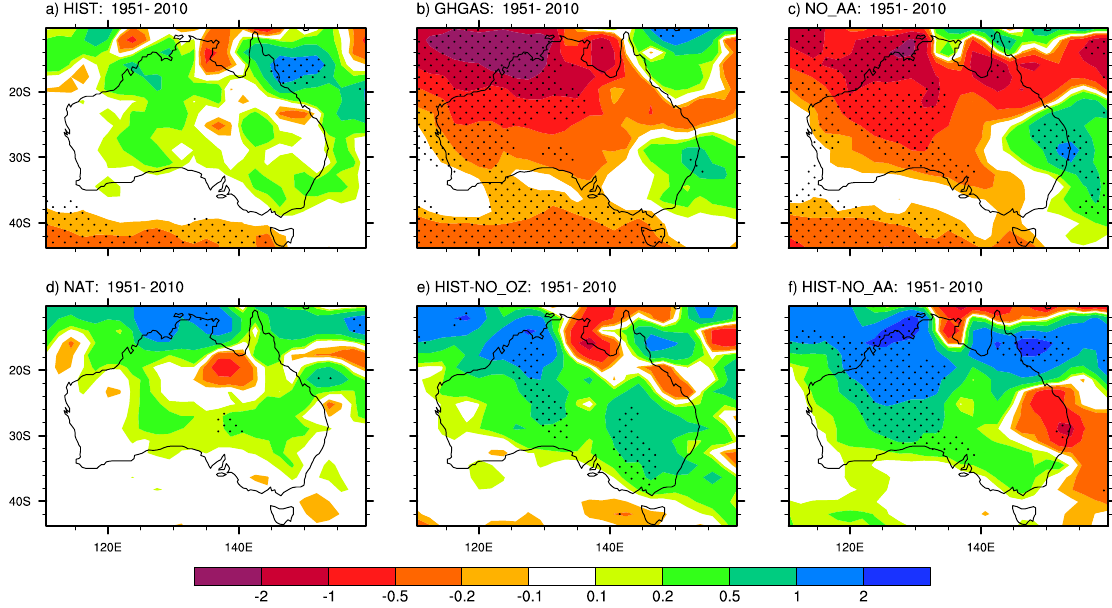
Fig. 13. Simulated DJFM rainfall trends (mmday − 1 century − 1 ) for 1951–2010, from (a) HIST, (b) GHGAS, (c) NO AA, (d) NAT, (e) HIST minus NO OZ, (f) HIST minus NO AA. Stippled trends are significant at 5%.